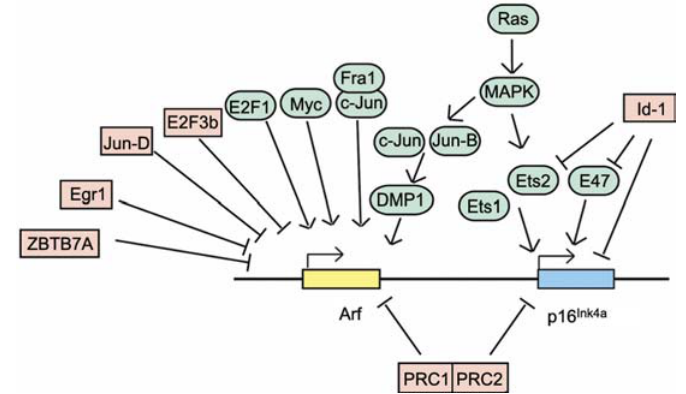
Figure 4 Regulation of the p16 Ink4a and Arf transcription. Green circles and red squares indicate activators and repressors, respectively, of p16 Ink4a and/or Arf transcription.